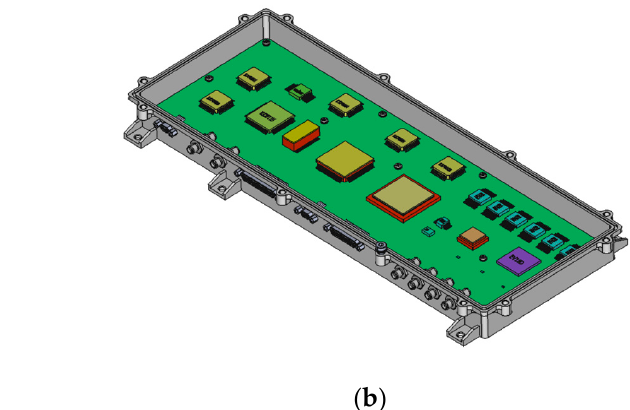
Figure 15. Functional block diagram of the S-STEP DCU.